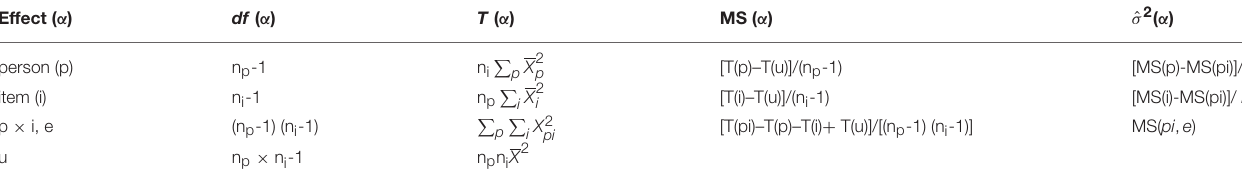
TABLE 1 | ANOVA formulas and notation for G study p × i design. Effect ( α )